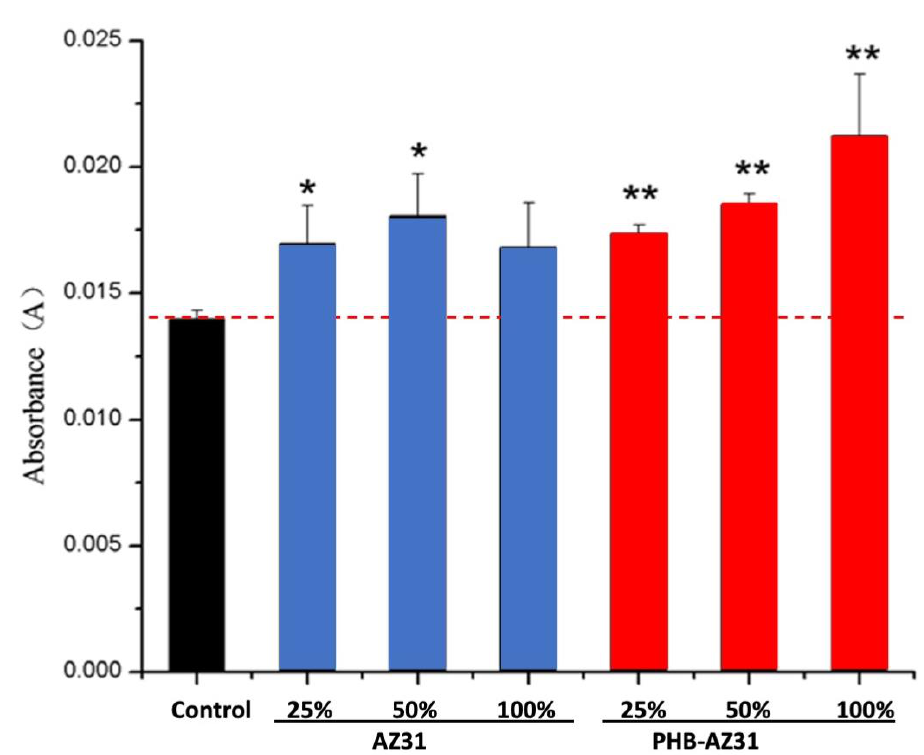
Figure 7. Total antioxidant capacity (T-AOC) contents of different groups. * significant difference ( p < 0.05); ** highly significant difference ( p < 0.01).